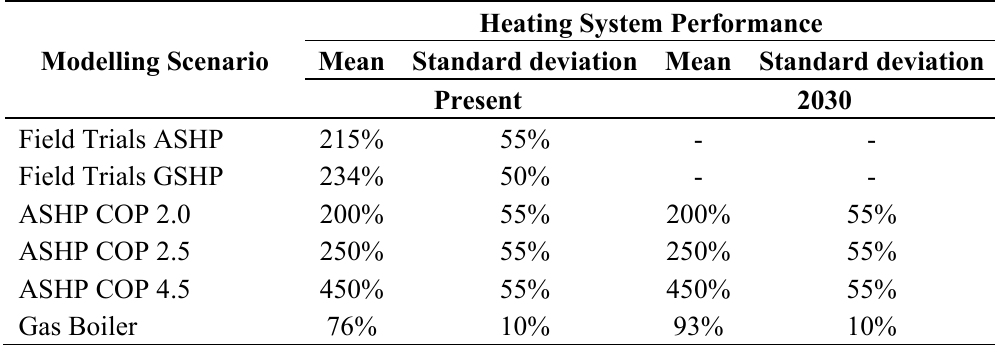
Table 1. Monte Carlo parameters for heating system